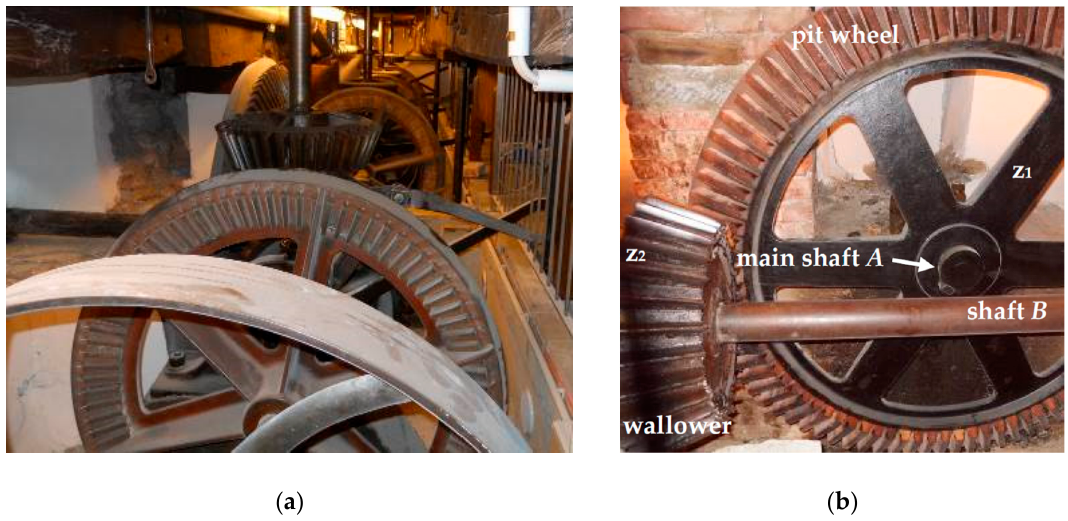
Figure 8. The Riviera mill: ( a ) Power transmission overview; ( b ) the first bevel gear multiplier. The rotation of the runner stone can be stopped by moving the bevel gear z 4 along the spindle vertical shaft C through a special lever (Figure 9b), until the contact between teeth z 3 and z 4 is interrupted.